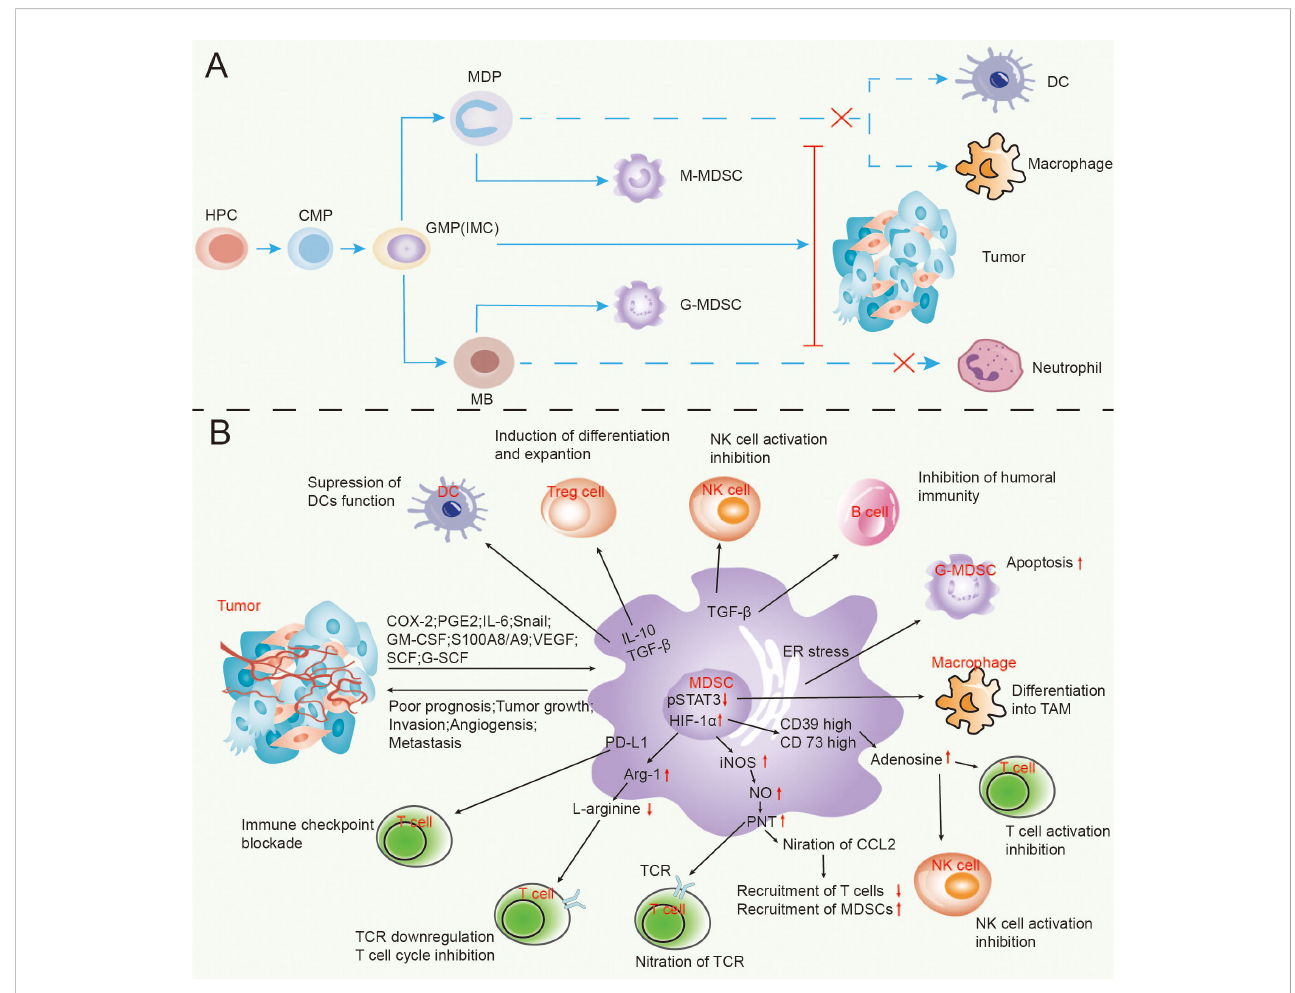
FIGURE 1 The process of MDSCs ’ formation in lung cancer (A) and the appliance of MDSCs exert tumour immunosuppressive effects (B)